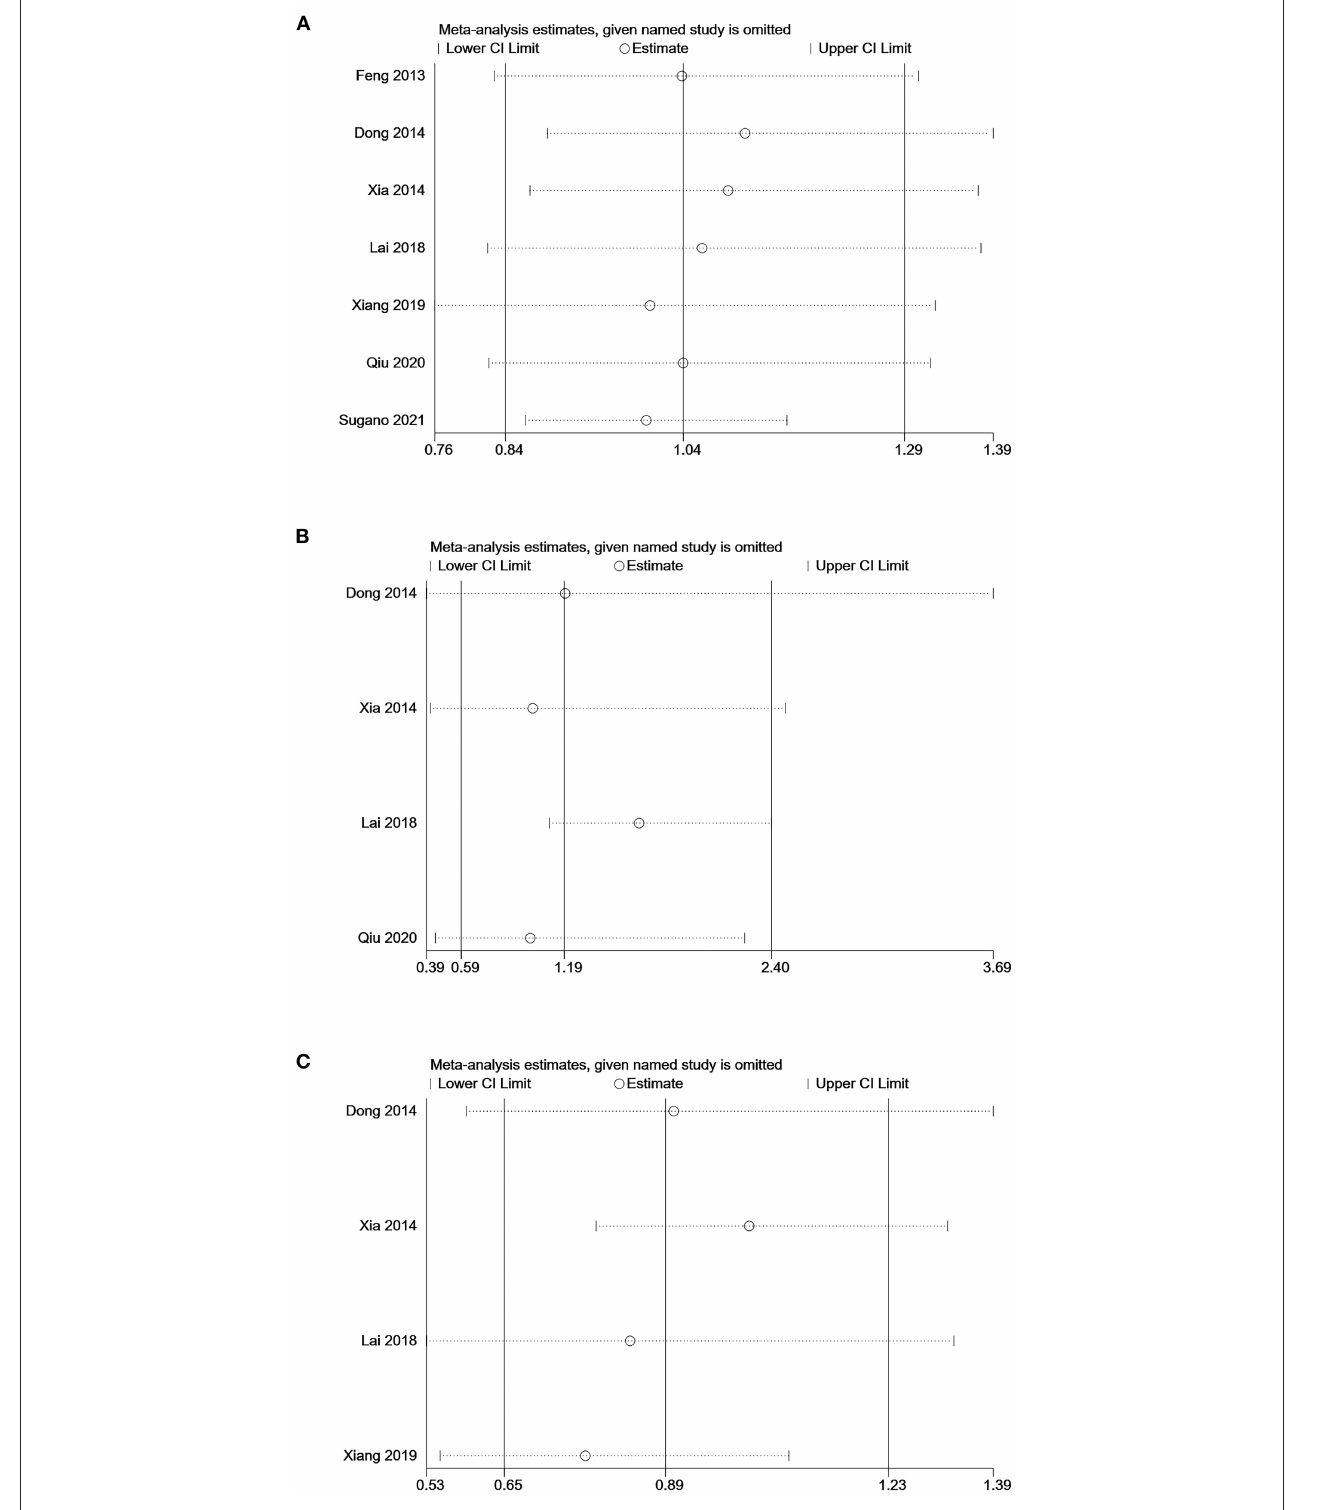
FIGURE 4 | Sensitivity analysis of the association between serum uric acid levels and mortality in PD patients. (A) comparison: low vs. middle, outcome: all-cause mortality; (B) comparison: high vs. low, outcome: all-cause mortality; (C) comparison: low vs. middle, outcome: cardiovascular mortality.